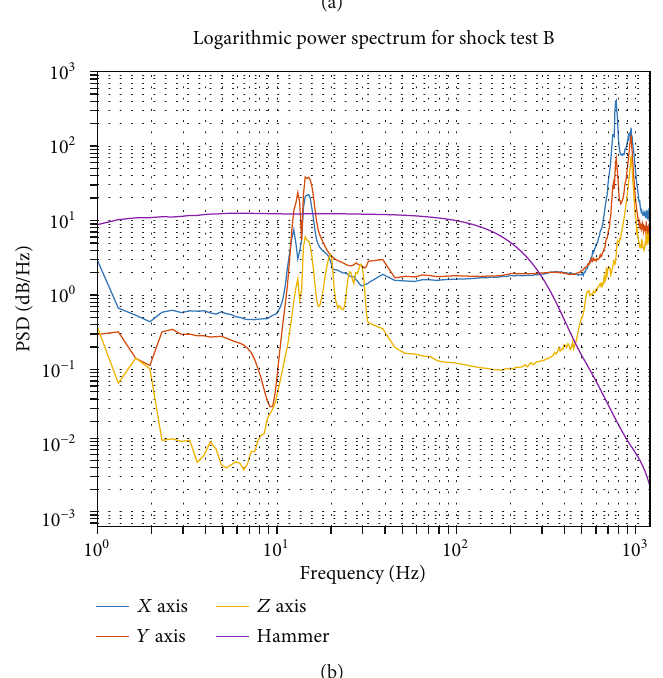
Figure 12: Frequency response for shock